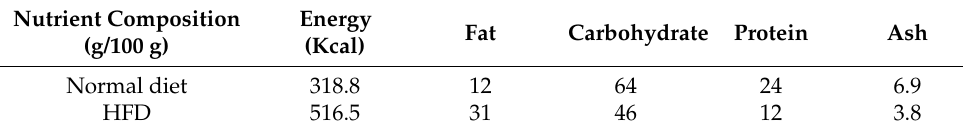
Table 1. Composition of rat